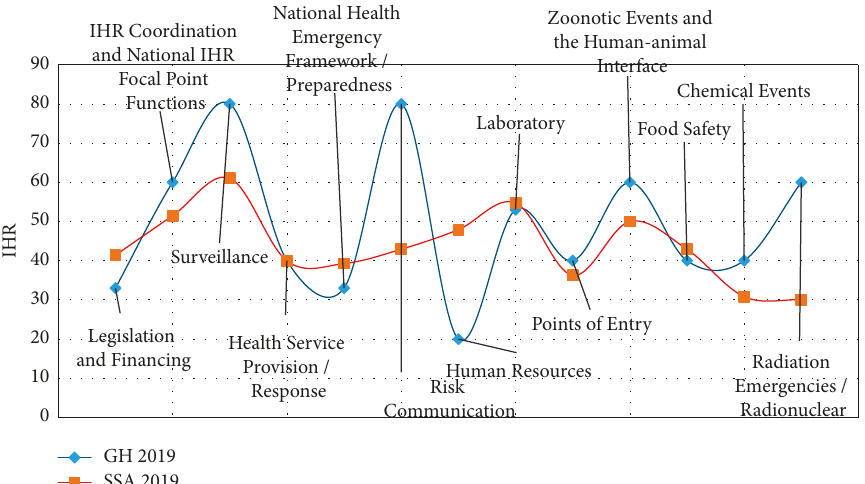
Figure 1: The International Health Regulations (IHR) scores of Ghana and the Sub-Saharan Africa (SSA) region average for